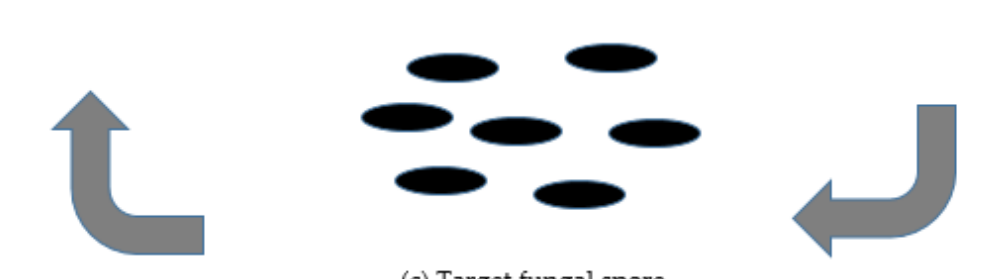
Figure 1. ( a ) Different nanomaterials as protectants used in plant protection. ( b ) Nanomaterials as transporters for several active ingredients such as fungicides. ( c ) Nanomaterials targeting different fungal pathogens. ( d ) The potentialities of nanomaterials to provide protection to the plant.